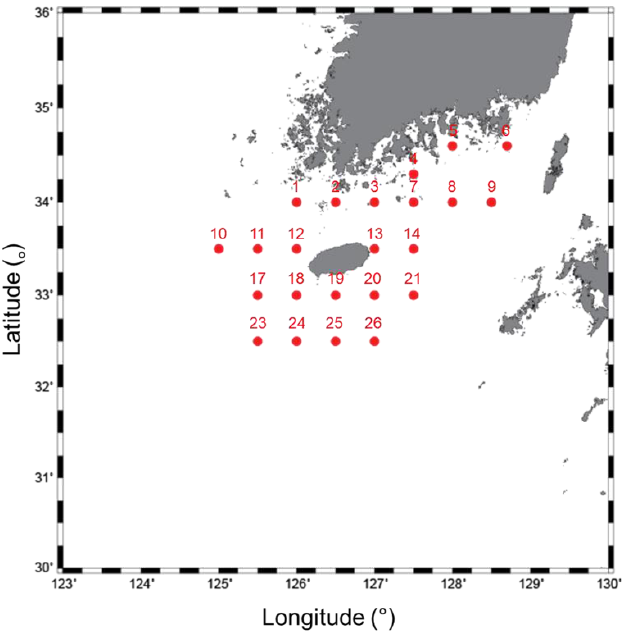
Figure 2. Acoustic survey sites in the Southern Sea and Jeju coastal waters.